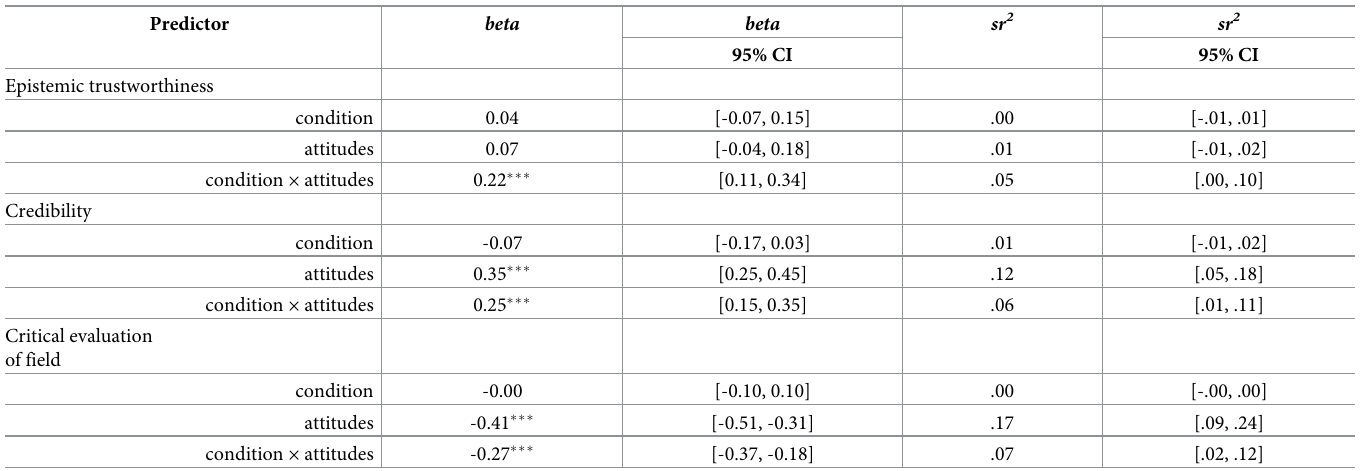
Table 4. Standardized regression results, Study